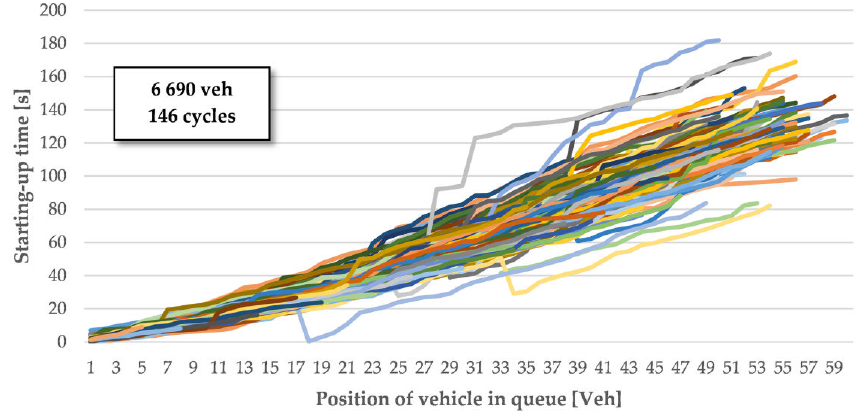
Figure 8. Starting-up times for the vehicles forming the maximum back-of-queues for a given lane controlled by traffic signal heads with the same signal control parameters, i.e., green signal and cycle length.